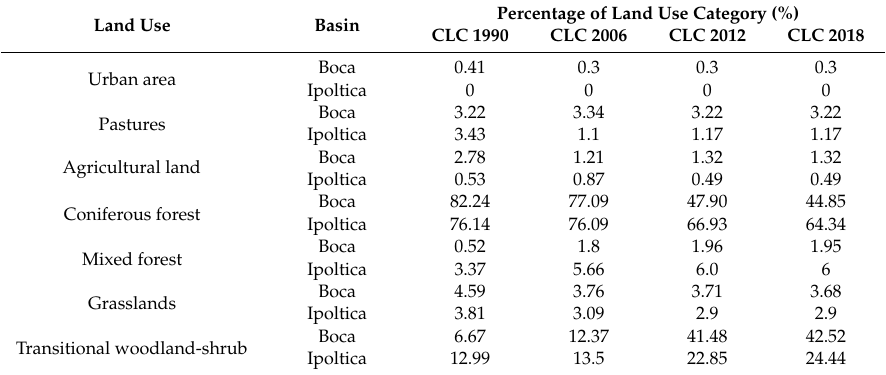
Table 4. The percentage of land use categories from CLC data (1990, 2006, 2012 and 2018). Land